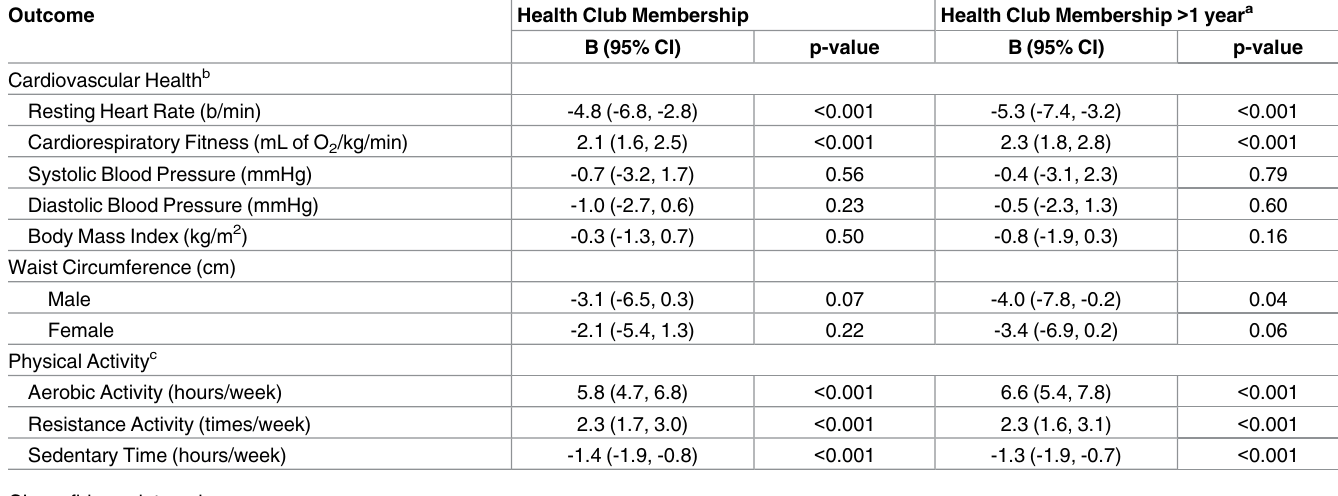
Table 5. Differencesin cardiovascularhealth and physical activity by health club